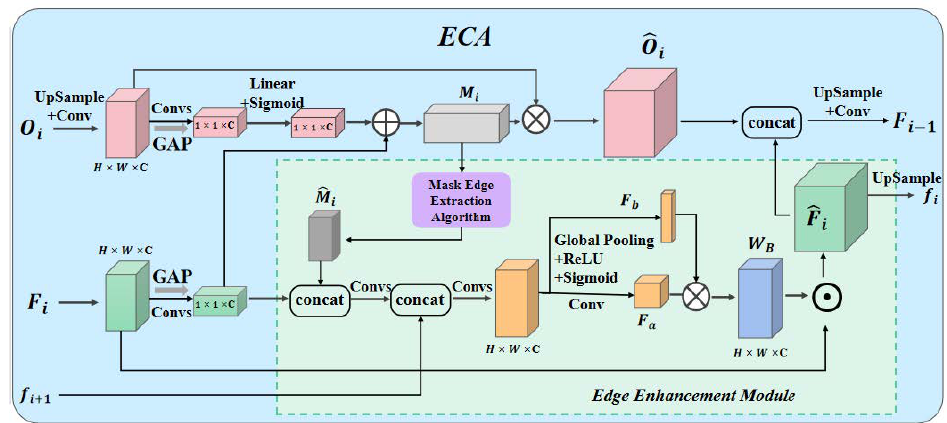
Figure 5. Edge-Enhanced Cross-Attention Module (ECA).